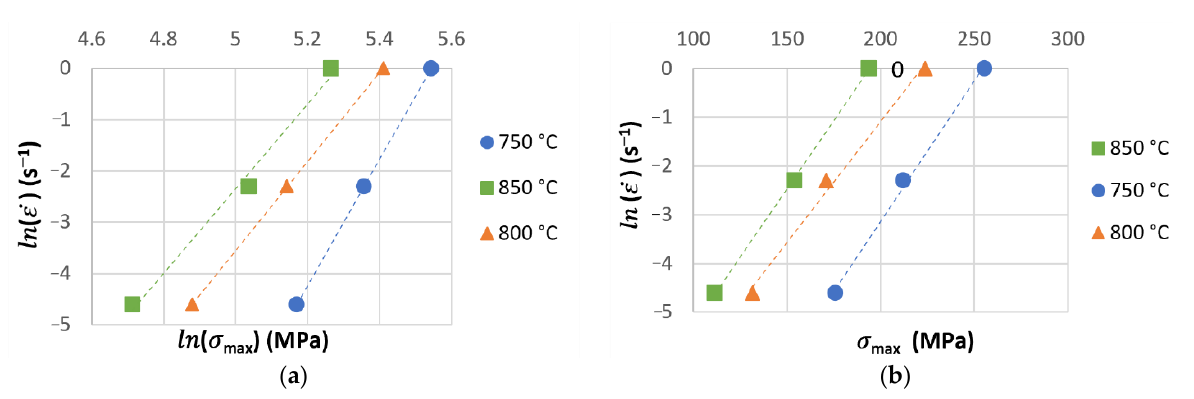
Figure 12. Relationships at different temperatures between ( a ) 𝑙𝑛𝜀̇ and 𝑙𝑛𝜎 𝑚𝑎𝑥 ( b ) 𝑙𝑛𝜀̇ and 𝜎 𝑚𝑎𝑥 . A linear relationship between 𝑙𝑛(𝜀̇) and 𝑙𝑛(𝜎 𝑚𝑎𝑥 ), as well as between 𝑙𝑛(𝜀̇) and 𝜎 , is observed; in fact, the experimental points are well interpolated by straight lines 𝑚𝑎𝑥 (dashed lines in Figure 12). By averaging the slopes of the lines, the mean values and the